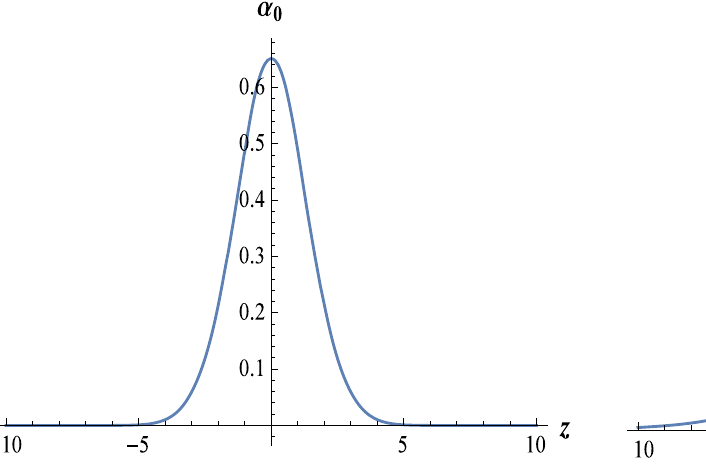
Fig. 4 The shape of the Elko zero mode α 0 ( z ) Eq. (73) in the thick brane model. The parameters are set to a = 1 and k = (cid:2) (cid:7) (cid:3) k a 4 ¯ z 2 e − k ¯ z 2 / 2 ¯ z d ¯ z is erf ( 1 + a 2 ¯ z 2 ) 2 0 2 (cid:19) (cid:18) − k z 2 as 4